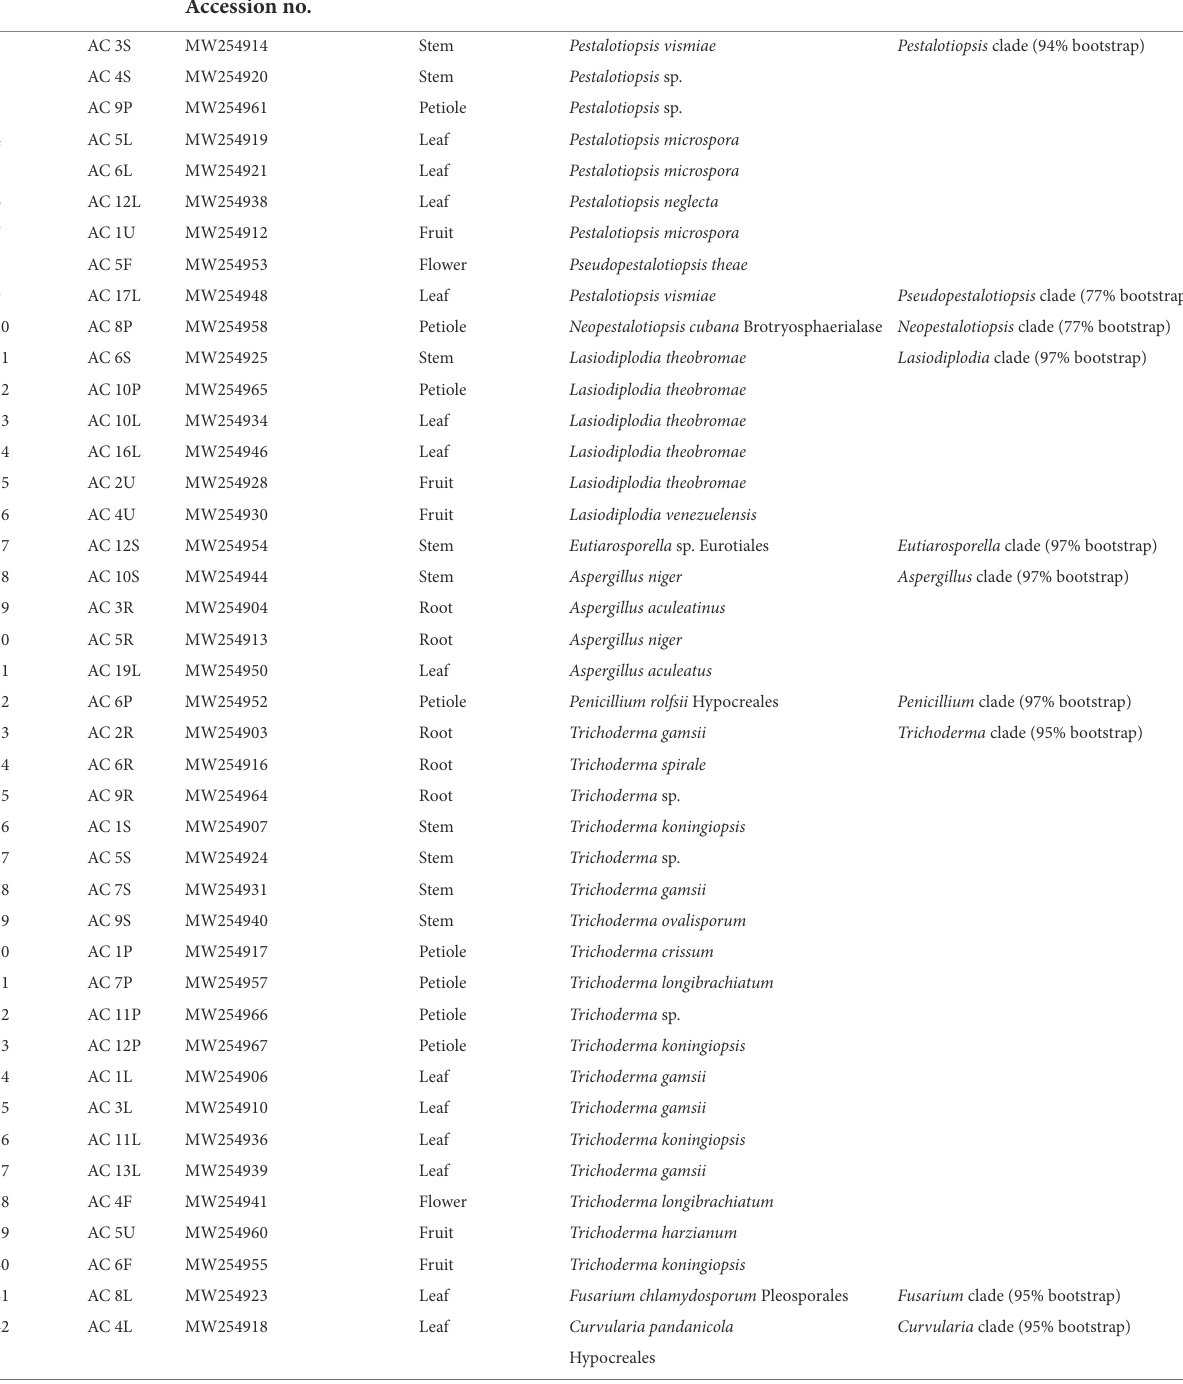
TABLE 3 Endophytic fungal orders from the phylum